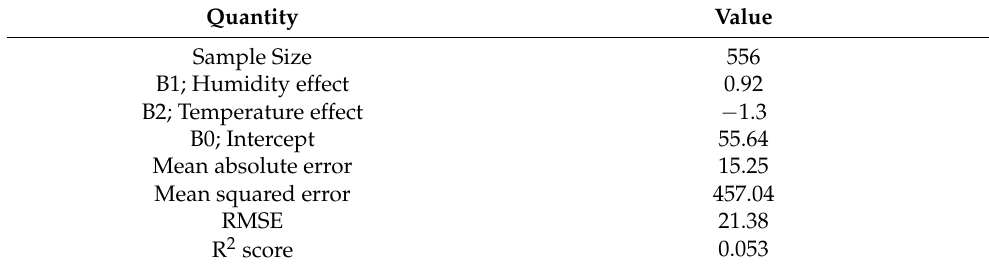
Figure 3. Correlation between humidity and COVID-19 cases in Mississippi, as a function of tem-